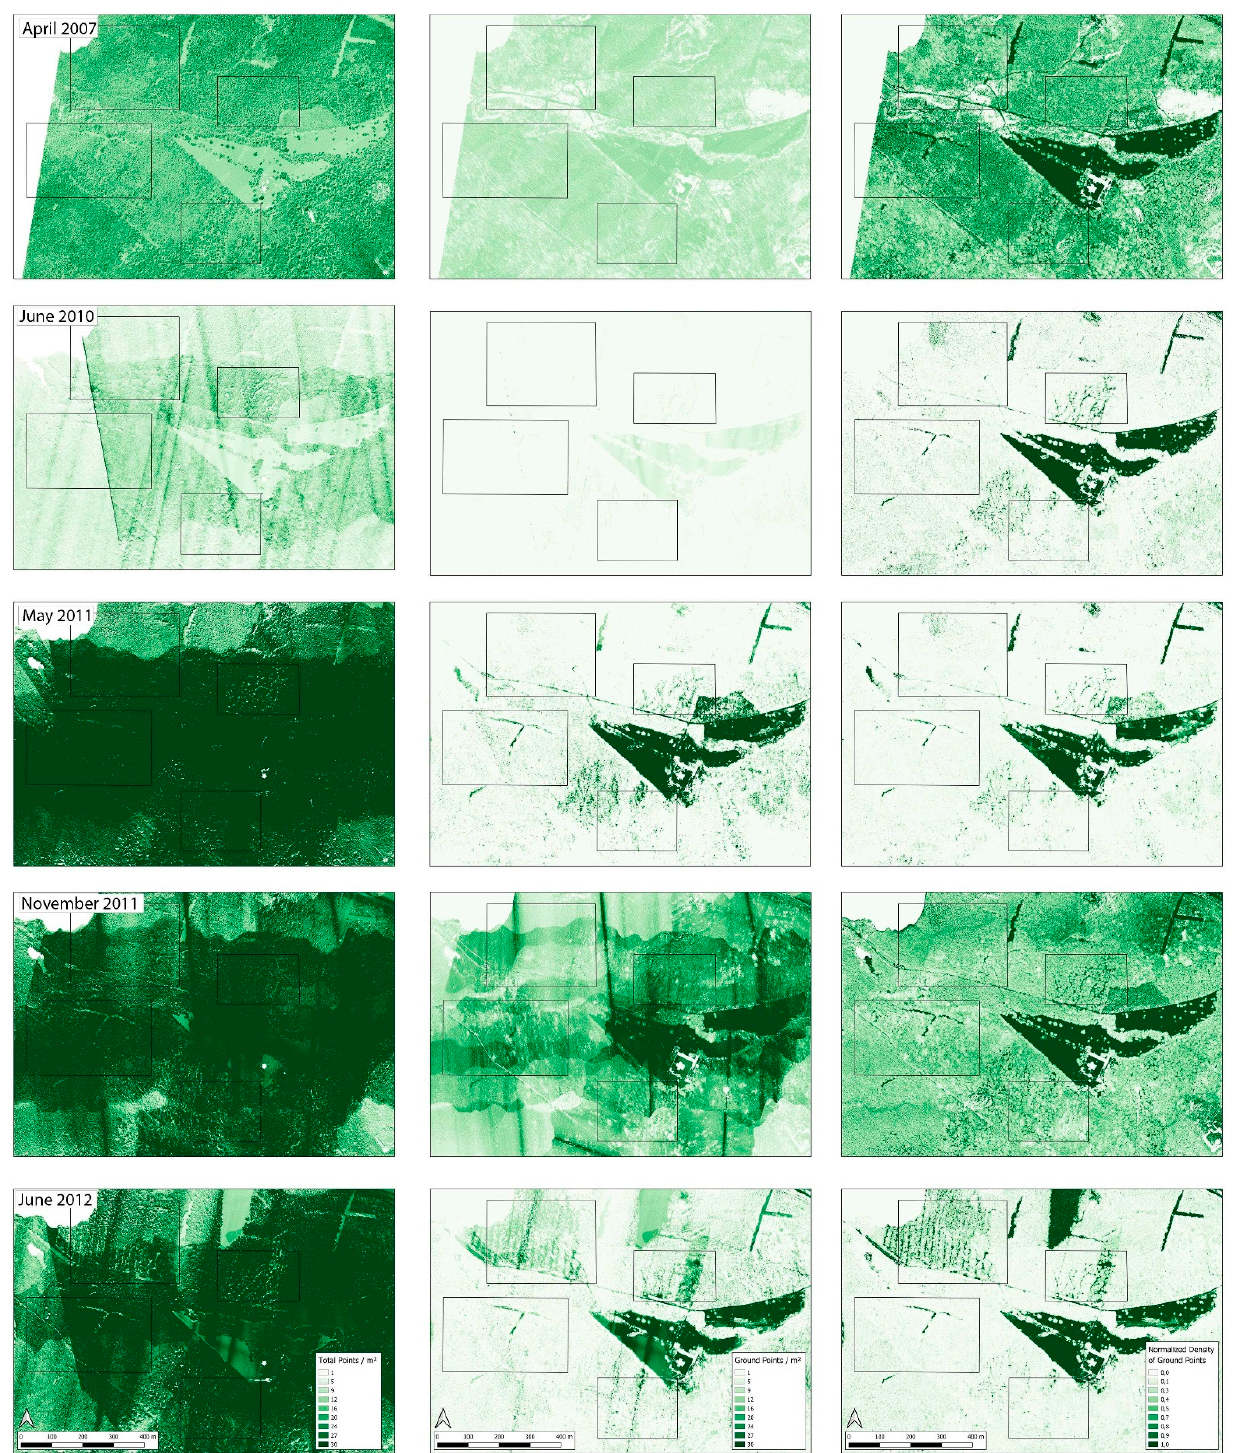
Figure 10. Point densities of all data acquisition flights. Left column: total point density; middle column: ground point density; right column: normalised ground point density. All images within each column bear the same classification. Normalised density: white spots indicate the absence of ground hits. Constant colour palette (0–1 weighted points/m 2 ).